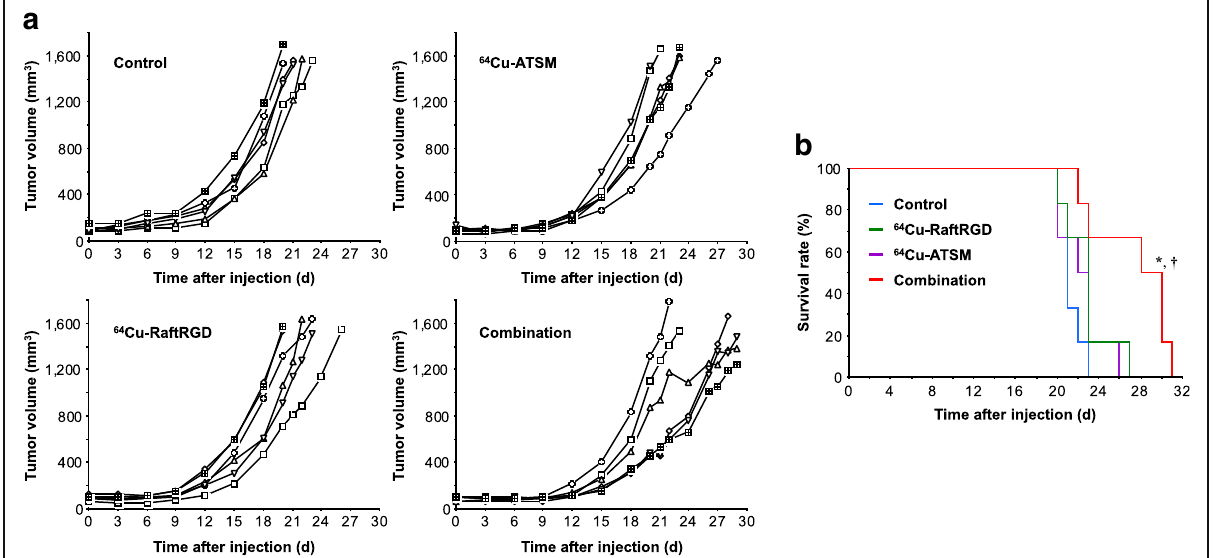
Fig. 3 Tumor growth curves ( a ) and Kaplan-Meier endpoint-survival curves ( b ) of U87MG tumor-bearing mice after single injection of the vehicle solution (control) or 37 MBq of 64 Cu-RaftRGD, 64 Cu-ATSM, or a combination (18.5 MBq for each agent). n = 6/group; * P < 0.01 and † P < 0.05 for the combination group vs. control group and vs. 64 Cu-RaftRGD or 64 Cu-ATSM group,